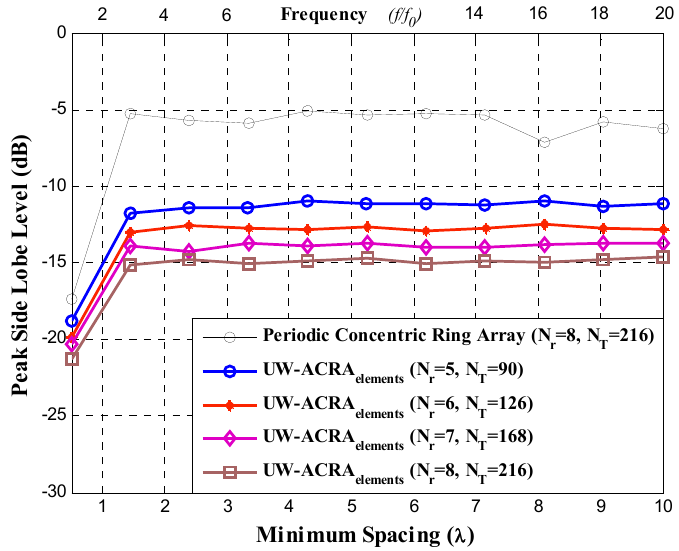
Figure 3. Peak sidelobe level ( PSLL ) performance of the aperiodic concentric rings array (UW-ACRA elements ).